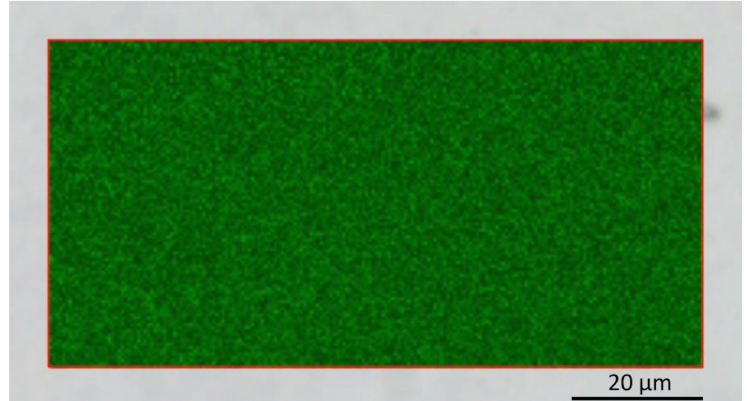
Figure 5. Two-dimensional Raman mapping of the coating surface of the sample D 4_ZnO . Green color corresponds to the spectrum of the studied latex polymer. A vibration band of sulfate anion at 975 cm − 1 was not